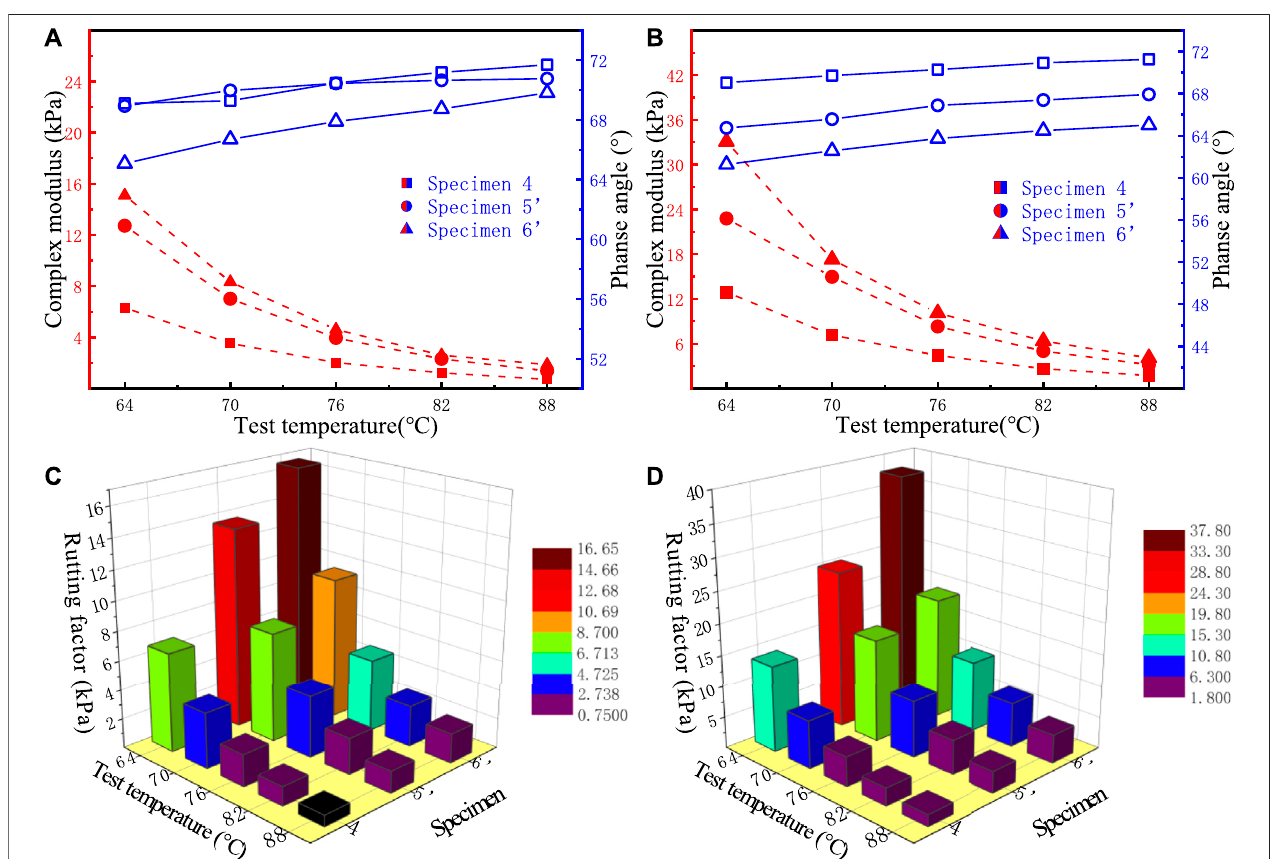
FIGURE 7 | Complex modules G* and phase angle δ (A) before RTFO-aged and (B) after RTFO-aged, rutting factor G*/ sin δ (C) before RTFO-aged and (D) after RTFO-aged.